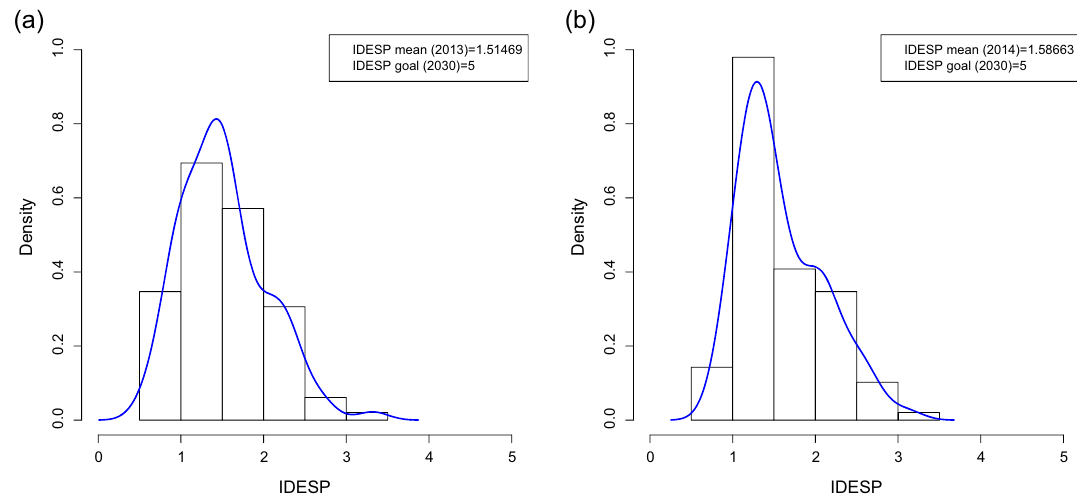
Figure 1. IDESP values distribution in Guarulhos, São Paulo State, Brazil (2013 – 2014). (a) Year 2013, (b) year 2014.